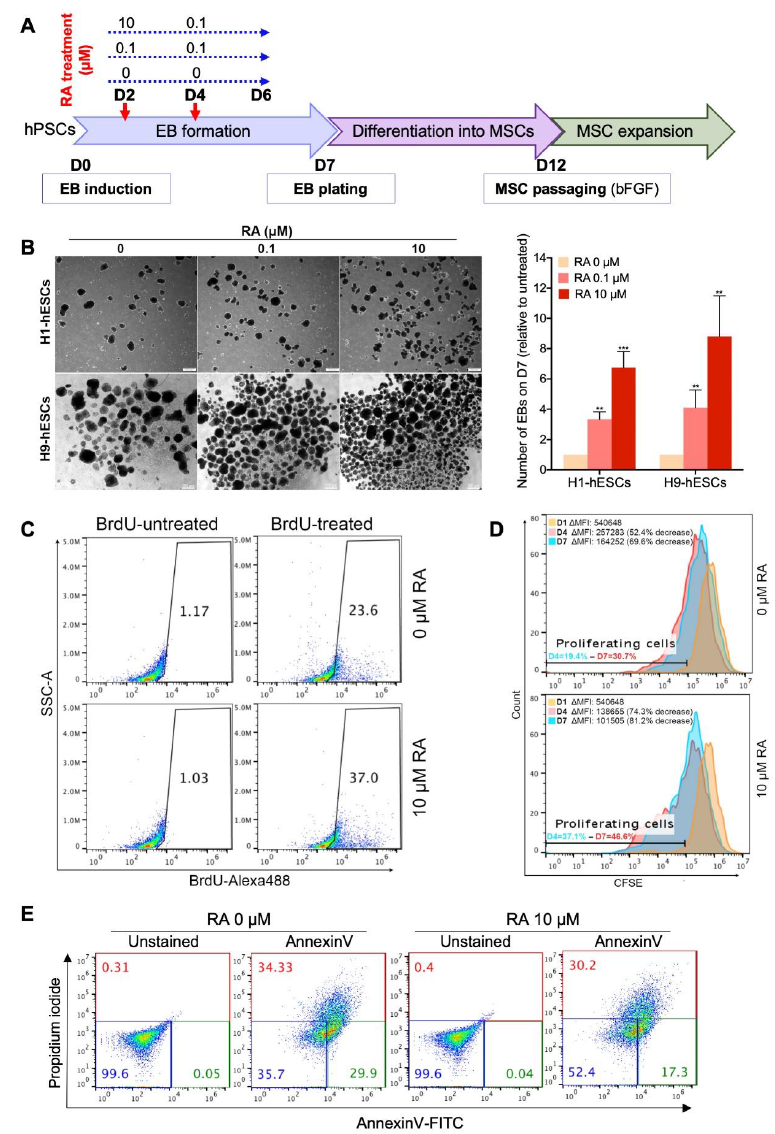
Figure 1. Short-term all- trans -retinoic acid (RA) treatment enhances embryoid body (EB) formation by inducing cell proliferation and survival. ( A ) Experimental scheme for the differentiation of human pluripotent stem cells (hPSCs) into mesenchymal stem cells (MSCs). ( B ) Representative images of H1 and H9 hESC-derived EBs showing the effect of RA concentration on EB formation ( n = 4). The EBs were quantified at D7 of differentiation. The results presented in the bar graph are means ± SD for three independent experiments. * p < 0.05, ** p < 0.01 and *** p < 0.001 versus untreated EBs (0 µM) (Dunnett’s test). ( C , D ) E ff ect of RA treatment of the proliferation of EB-forming cells. ( C ) Flow cytometry analysis of BrdU incorporation during 19 h in D3-old H9-derived EBs treated or not